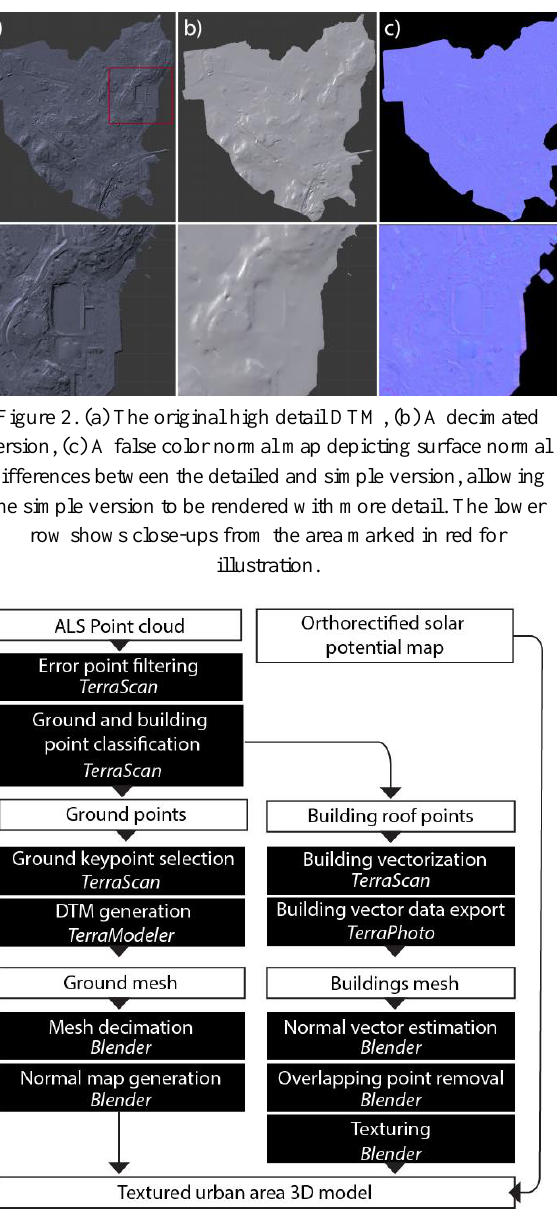
Figure 3. An overview of the processing steps for producing the urban 3D model. The datasets are denoted in white boxes, whereas the processing steps are in black.